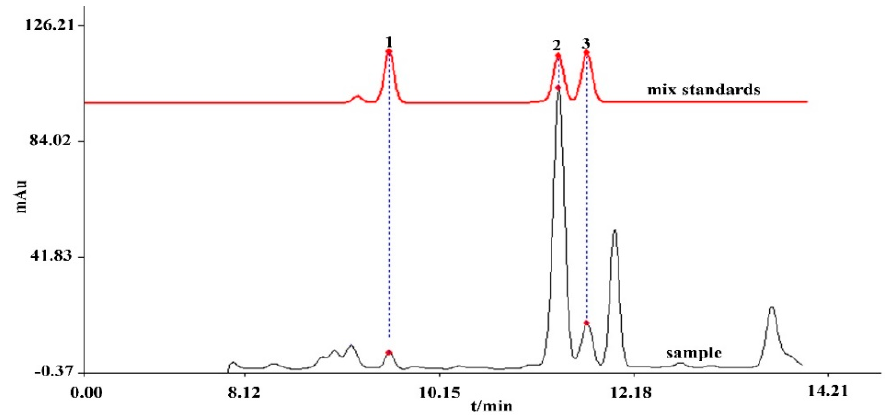
Figure 4. HPLC chromatography of G. rigescens . Peak 1 (swertiamarin), peak 2 (gentiopicroside), and peak 3 (sweroside) for mixed standards and samples.